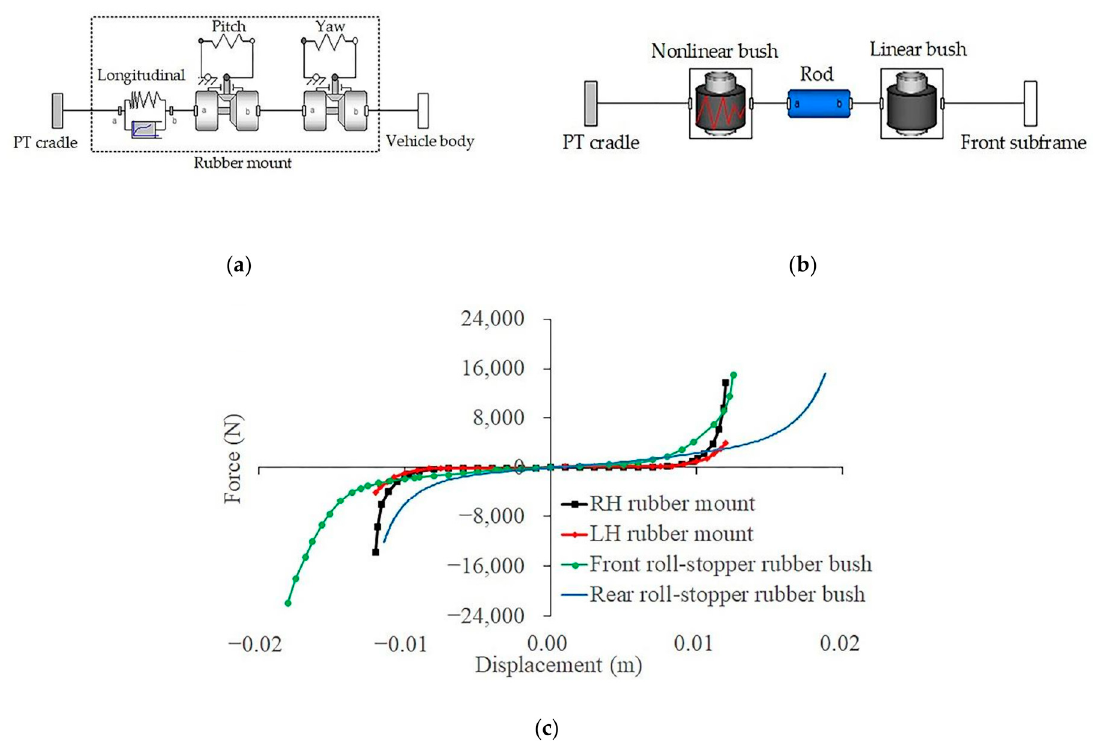
Figure 3. PT cradle mounting models: ( a ) 3-DOF RH and LH rubber mounts; ( b ) longitudinal front and rear roll-stopper rubber bushes and rigid rod; ( c ) longitudinal nonlinear stiffness properties.